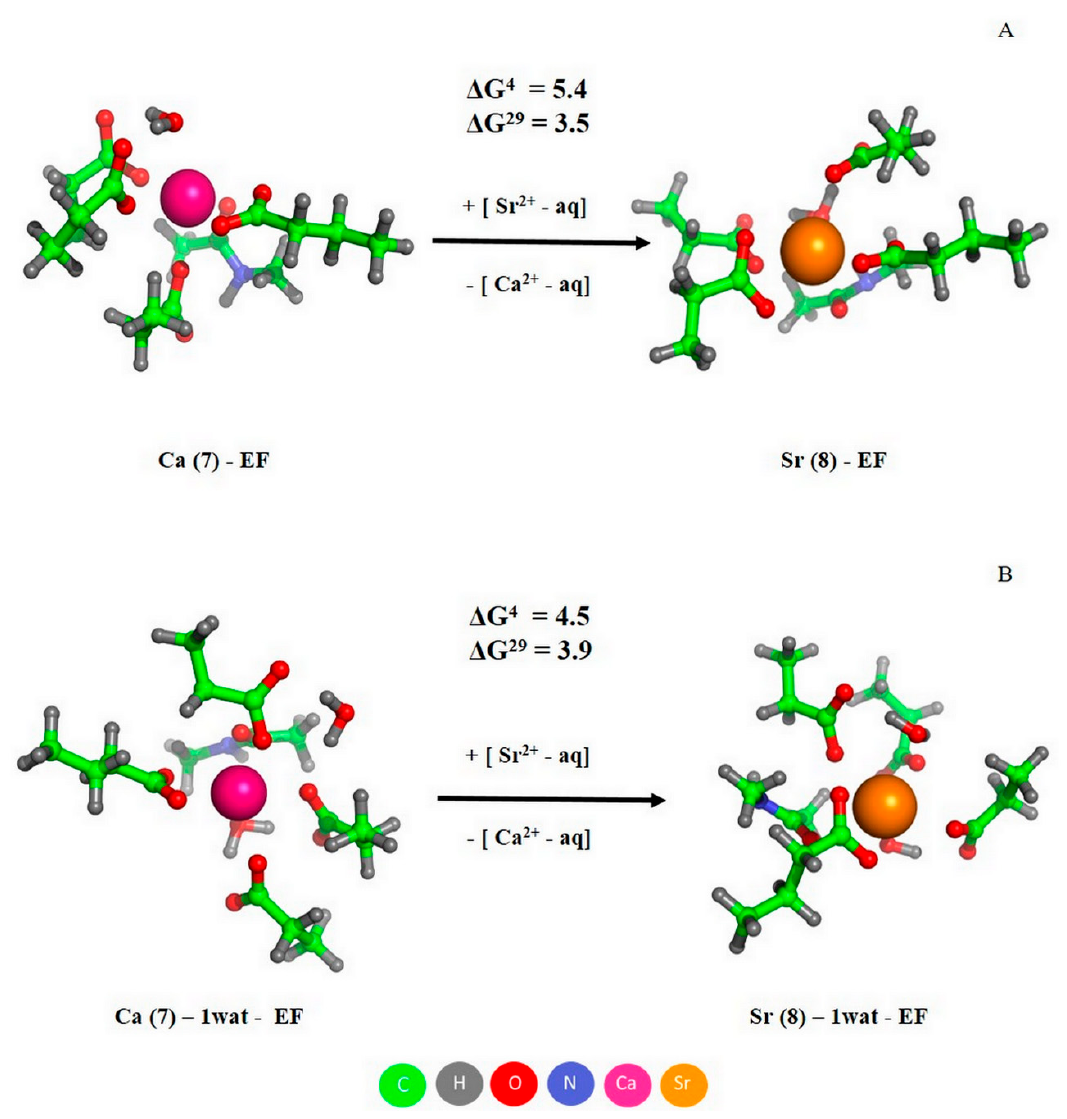
Figure 9. The optimized structures of Ca 2+ /Sr 2+ -loaded EF site of PA with 8-coordinated Sr 2+ , and free energies of metal exchange (in kcal/mol). Sr 2+ acquires an additional bond at the expense of either bidentate Asp binding ( A ) or an additional water molecule ( B ). Metal coordination number is indicated in parentheses in the complex name.